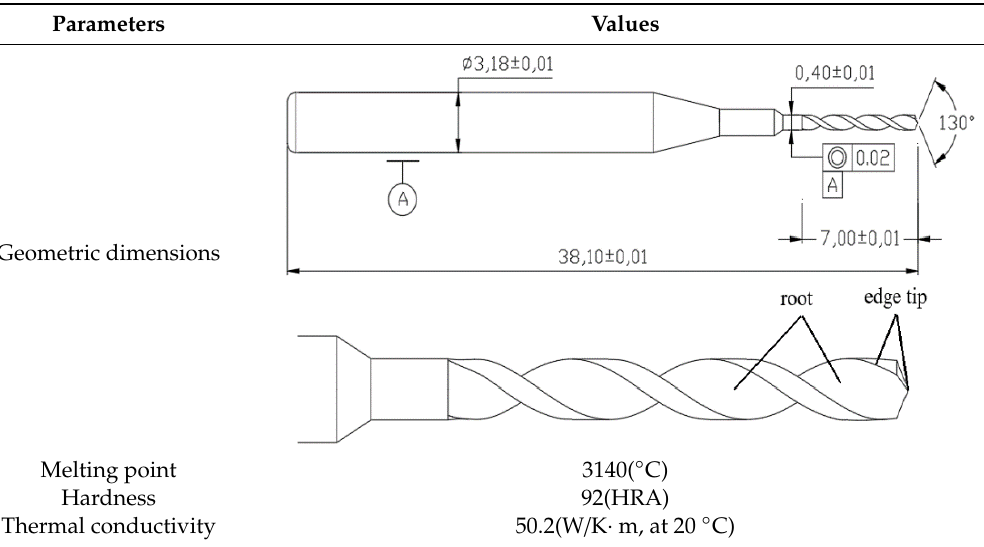
Table 1. Geometric dimensions and the physical properties of the tool electrodes.